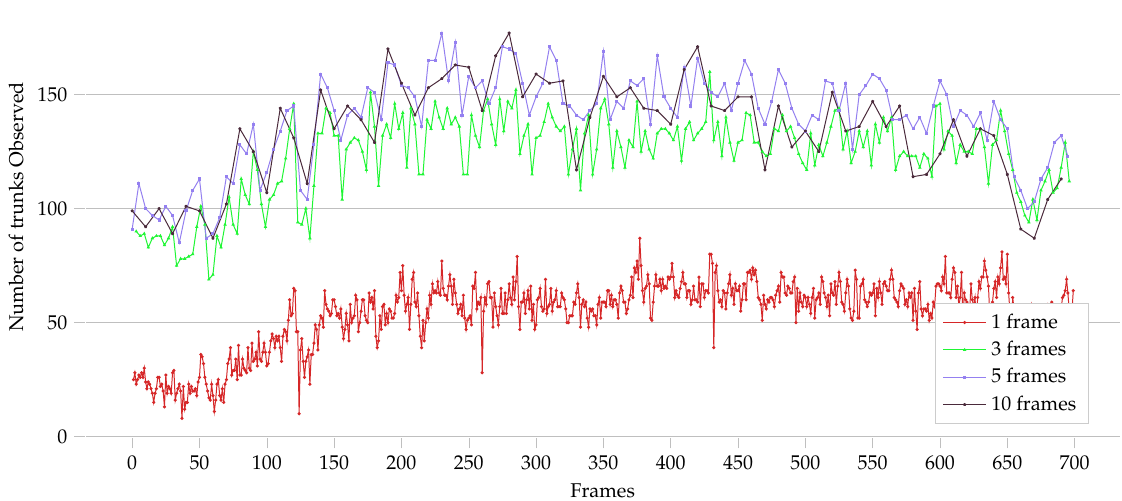
Figure 8. Number of trunks observed for different number of consecutive aggregated